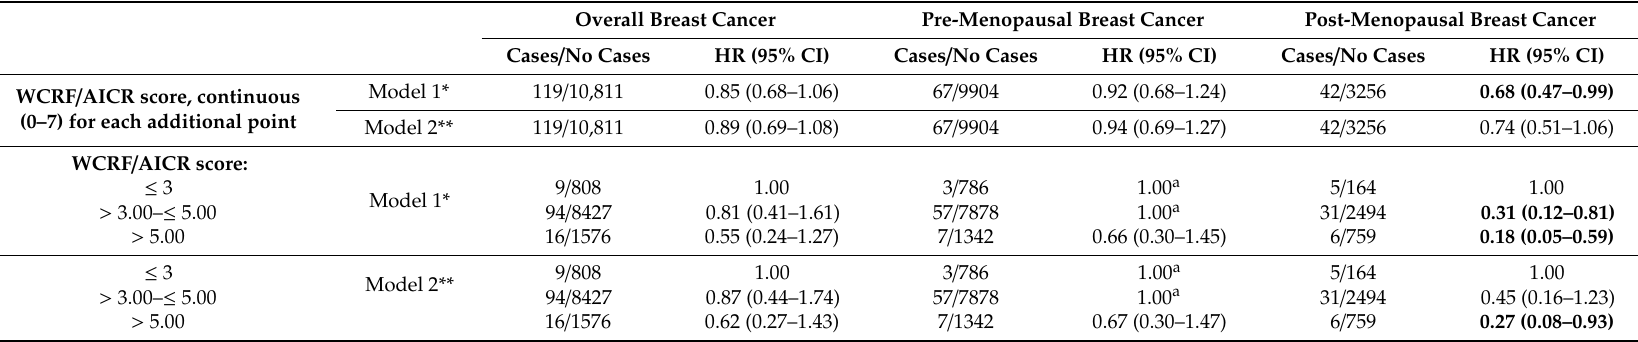
Table 2. Associations between adherence to the WCRF / AICR lifestyle score and overall, pre-menopausal, and post-menopausal confirmed breast cancer risk. Overall Breast